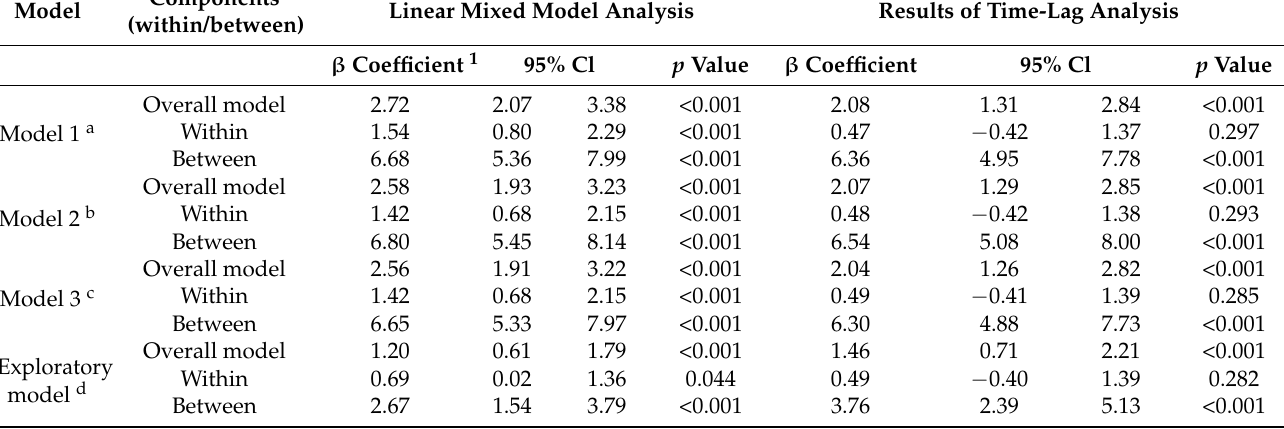
Table 3. Results of linear mixed models analyses and time-lag